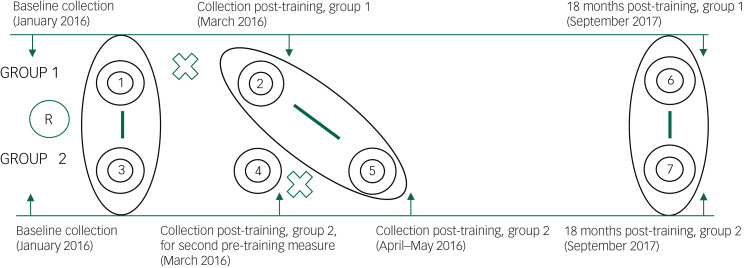
The design of the pilot trial in which this study is inscribed.Our study is inscribed within a pilot trial that aimed to assess the mental health capacities of primary care physicians (PCPs) after their participation in Mental Health Gap Action Programme (mhGAP)-based training. For the purposes of this study, we rely on a repeated measures design (as shown in Fig. 1) to improve understanding of the influence of mental health knowledge, attitudes and self-efficacy on self-reported referrals to specialised mental health services at three time periods: pre-training (circles 1 and 3), immediately post-training (circles 2 and 5) and 18 months post-training (circles 6 and 7). X represents the implementation of the training. R represents when PCPs were randomized to either group 1 or group 2. The circled areas depict the pooling of group 1 and group 2 over three time periods. This study relies on the secondary data analysis of data collected during the pilot evaluation of the mhGAP-based training in the Greater Tunis area of Tunisia. The pilot study design in which this study is inscribed has been described in detail elsewhere.6